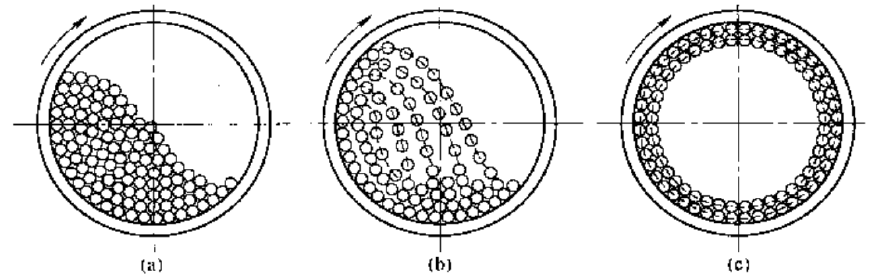
Figure 6. Motion state of the media in the mill. ( a ) Falling state. ( b ) Throwing state. ( c ) Centrifugal state. When the mill speed was set at 12.8 r/min, the grinding concentration at 60%, and the filling ratio at 35%, grinding tests with durations of 10, 20, 30, and 40 min were respectively conducted, with results shown in Tables 5 and 6. When the mill speed was set at 85 r/min, the grinding concentration at 60%, and the filling ratio at 35%, grinding tests with durations of 2, 4, 6, and 8 min were respectively conducted, with results shown in Tables 8–11. The corresponding curves are shown in Figures 7–10.